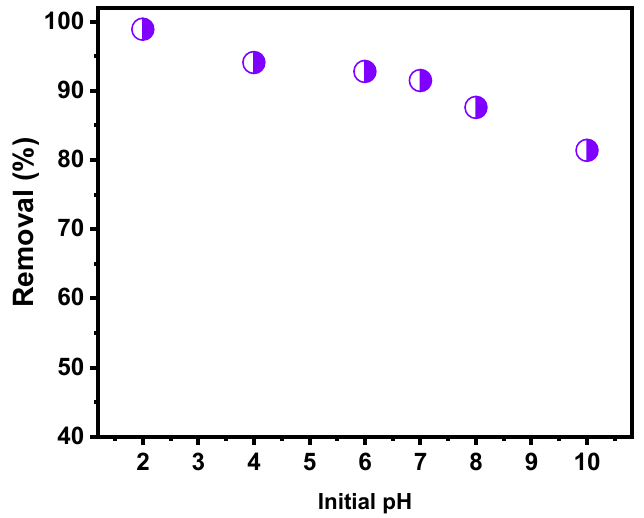
Figure 10. pH effect on the EB dye removal onto BC6. Adsorption experimental conditions: the initial adsorbate concentration was 150 m L − 1 ; the contact time was 4 h; the temperature was 23 °C; adsorbent dosage of 1.5 g L − 1 .